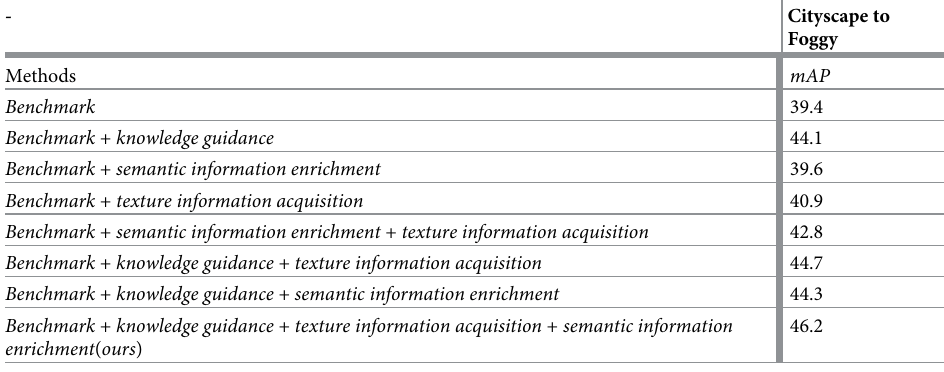
Table 3. Ablation experimental results of the model on the “Cityscape to Foggy”